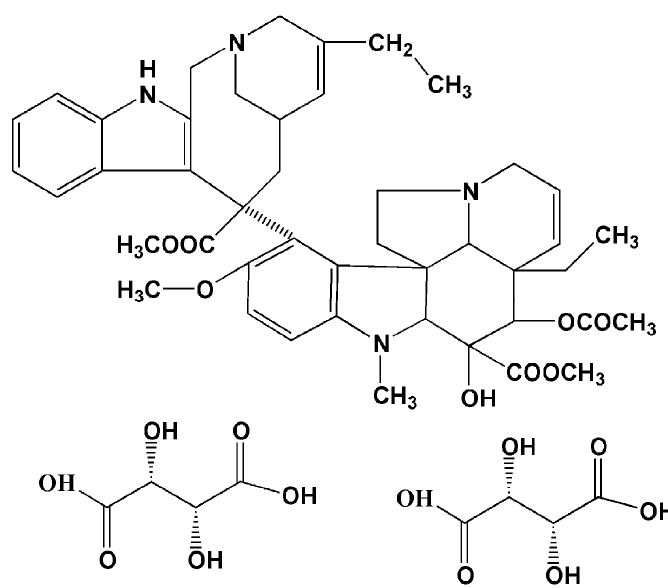
Figure 1. Chemical structure of vinorelbine tartrate